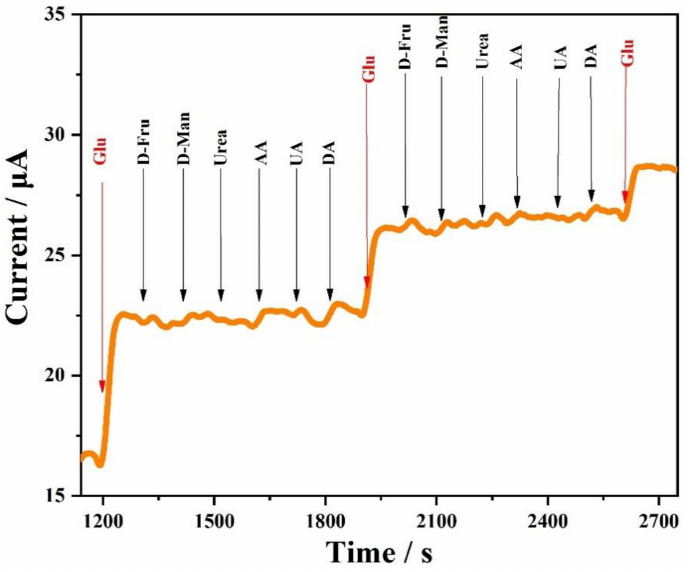
Figure 7. The anti–interference of Cu@Co–MOF/GCE sensing 0.1 mM Glu with 0.01 mM